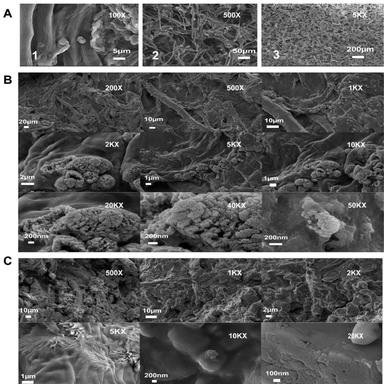
A, B and C are the SEM images of PS, PSB and PSH, respectively.